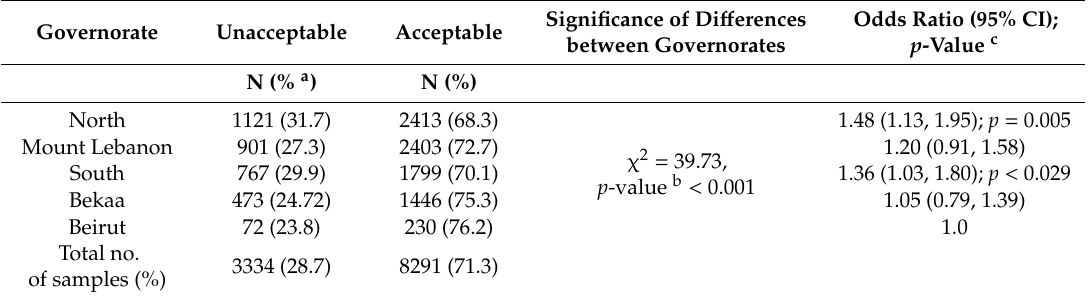
Table 2. The distribution of total food samples that were found to be microbially unacceptable or acceptable by the Ministry of Public Health (MoPH) across Lebanese governorates (administrative divisions of